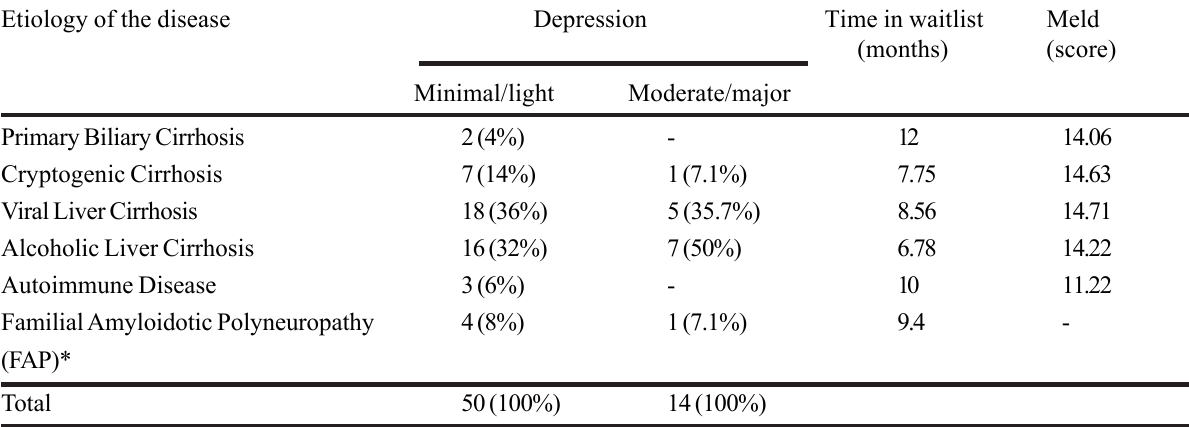
TABLE 2 - Clinical data and evaluation of depression in patients listed for liver transplantation Etiology of the disease